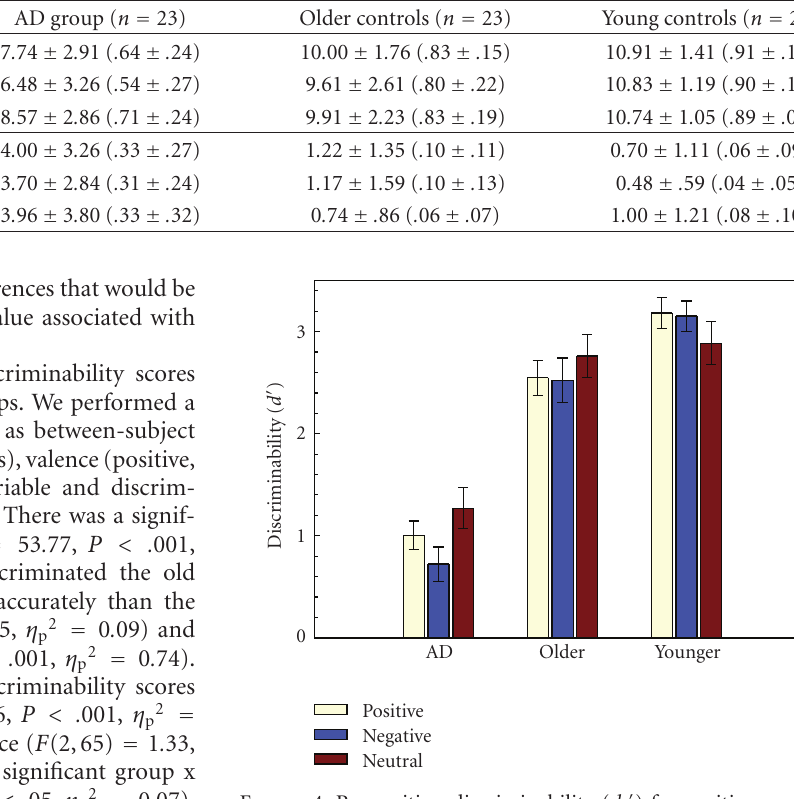
Figure 4: Recognition discriminability ( d (cid:3) ) for positive, negative and neutral pictures in the AD and control groups. Error bars rep- resent the standard error of the